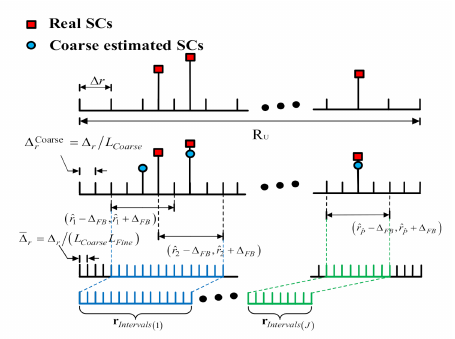
Figure 3. Diagram of candidate distributed intervals of SCs in the coarse